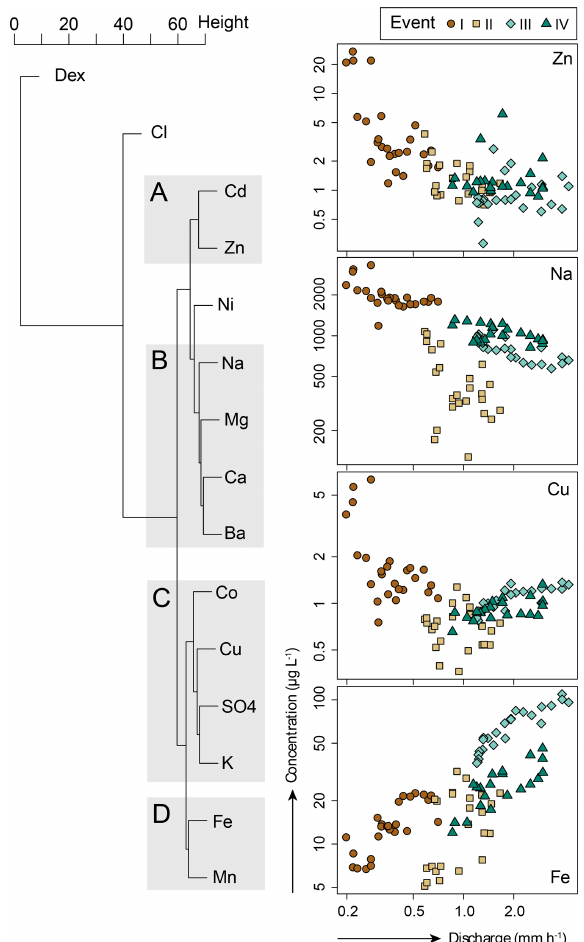
D ex based on the magnitude and timing of changes in streamflow concentrations compared to the baseflow concentration ( R x ; Eq. 2) during the four events (I–IV), and concentration–discharge relation- ships for one solute from each group